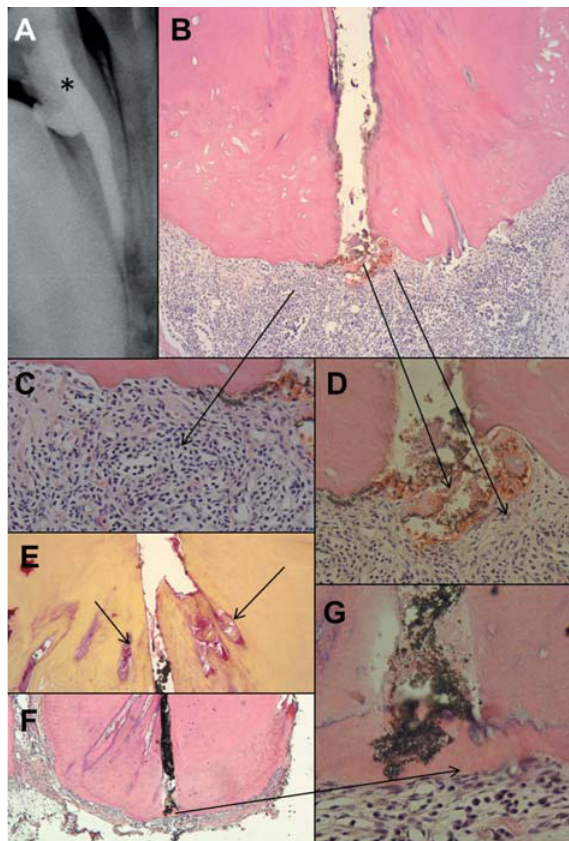
Figure 3- Representative images of the Sealapex® group. (A) Radiographic examination (*) 180 days after (cid:27)(cid:10)(cid:10)(cid:11)(cid:12)/(cid:13)!<(cid:25)(cid:11)/(cid:11)(cid:12)(cid:5)(cid:10)%(cid:13)=(cid:8)(cid:21)(cid:18)(cid:13)(cid:16)>(cid:20)(cid:13)?(cid:5)(cid:12)(cid:7)(cid:25)(cid:5)(cid:4)(cid:11)C(cid:13)(cid:24)(cid:11)(cid:3)(cid:31)(cid:13)(cid:15)(cid:2)(cid:7)(cid:31)(cid:11)(cid:12)/(cid:13)(cid:10)(cid:5)CI(cid:13)(cid:7)(cid:29)(cid:13) complete closure of the main canal [×100; hematoxylin (cid:14)(cid:13)(cid:3)(cid:7)(cid:15)(cid:11)(cid:12)(cid:13)(cid:16)(cid:17)(cid:18)(cid:19)(cid:18)(cid:20)(cid:21)(cid:18)(cid:13)(cid:16)(cid:22)(cid:20)(cid:13)(cid:23)(cid:3)(cid:24)(cid:3)(cid:25)(cid:3)(cid:13)(cid:11)(cid:12)(cid:26)(cid:5)(cid:4)(cid:4)(cid:5)(cid:6)(cid:7)(cid:25)(cid:9)(cid:13)(cid:11)(cid:12)(cid:27)(cid:10)(cid:6)(cid:25)(cid:5)(cid:6)(cid:3)(cid:13)(cid:16)(cid:5)(cid:25)(cid:25)(cid:7)(cid:31)(cid:20)(cid:13) !"#$$%(cid:13) (cid:17)(cid:18)(cid:19)(cid:18)(cid:21)(cid:18)(cid:13) (cid:16)’(cid:20)(cid:13) ?K(cid:10)(cid:30)(cid:13) (cid:15)(cid:6)K(cid:4)(cid:30)(cid:13) (cid:31)(cid:11)(cid:6)(cid:2)(cid:13) (cid:4)(cid:11)(cid:10)(cid:28)(cid:13) (cid:11)(cid:12)(cid:26)(cid:5)(cid:4)(cid:4)(cid:5)(cid:6)(cid:7)(cid:25)(cid:9)(cid:13) (cid:11)(cid:12)(cid:27)(cid:10)(cid:6)(cid:25)(cid:5)(cid:6)(cid:3)(cid:13)(cid:5)(cid:12)(cid:28)(cid:13)(cid:4)(cid:11)(cid:12)(cid:3)(cid:25)(cid:5)(cid:10)(cid:11)L(cid:3)(cid:28)(cid:13)(cid:6)(cid:11)(cid:15)(cid:15)K(cid:3)(cid:13)(cid:16)(cid:5)(cid:25)(cid:25)(cid:7)(cid:31)(cid:15)(cid:20)(cid:13)!"#$$%(cid:13)(cid:17)(cid:18)(cid:19)(cid:18)(cid:21)(cid:18)(cid:13)(cid:16)(cid:19)(cid:20)(cid:13) Gram-negative microorganisms in cementum lacunae (arrows) [×400; Brown and Brenn (B.B.)]. (F) Panoramic view [×100; H.E.]. (G) Newly formed cementum in the vicinity of the main canal (arrow) [×400; H.E.]